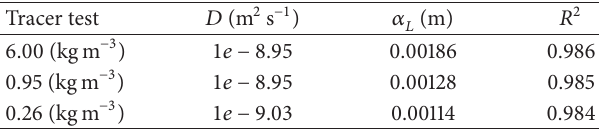
Table 2: Values of diffusion and longitudinal dispersivity calculated using self-potential signals registered at each electrode along the column using a hydrogeophysical inversion